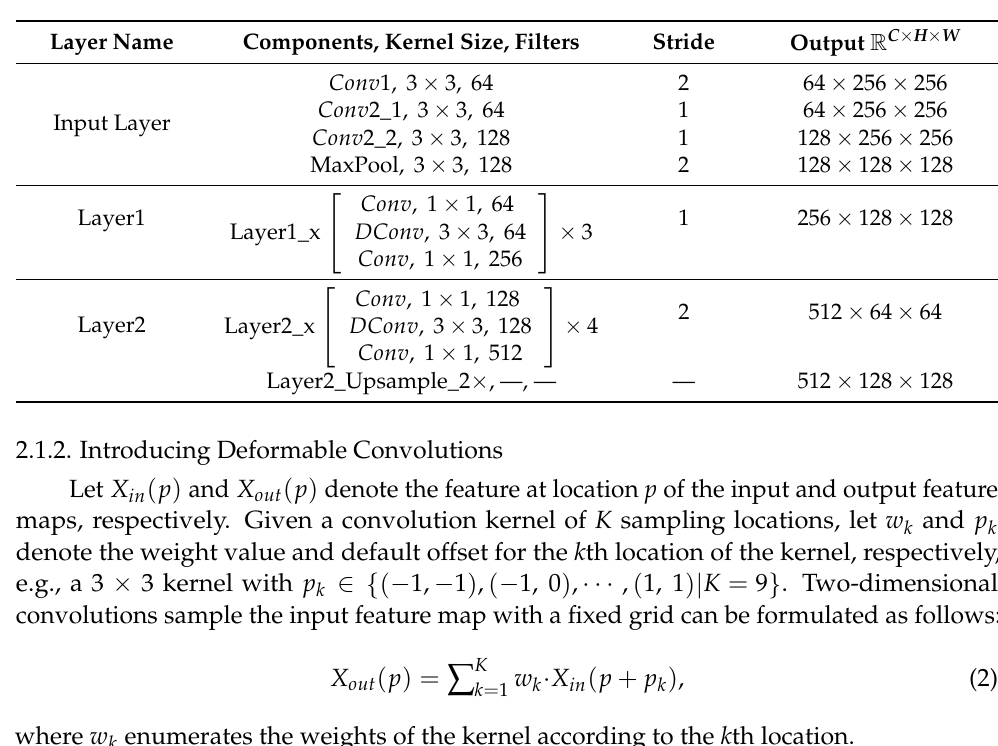
Table 1. The detailed architecture of the backbone